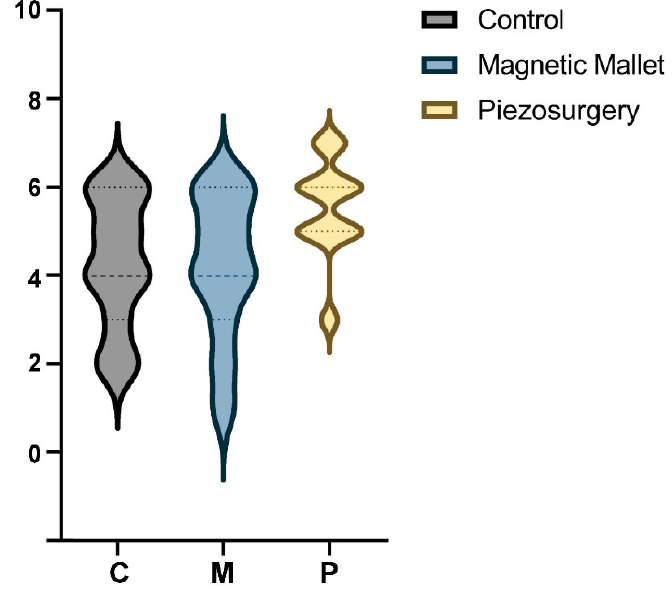
Figure 3. Violin plot of pain distribution (VAS).